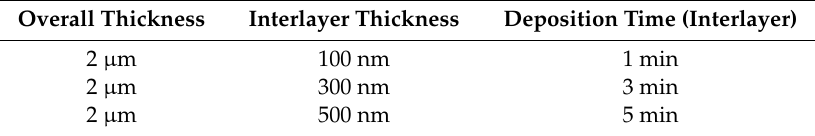
Table 1. Coatings studied for tool life and micro-mechanical property evaluation.